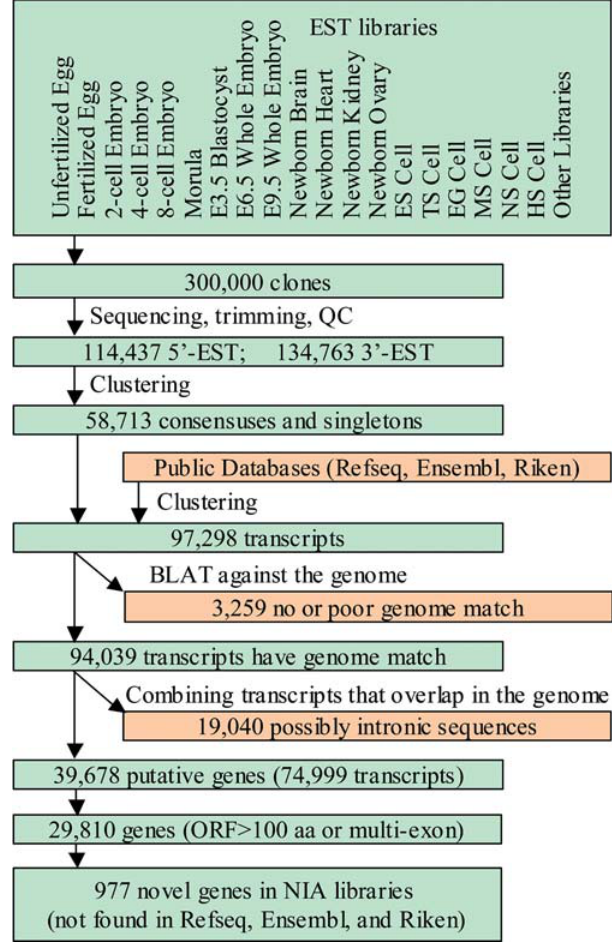
Figure 1. Flow Chart of Sequence Data Analysis Using TIGR gene indices clustering tools (Pertea et al. 2003), 249,200 ESTs were clustered, generating 58,713 consensuses and singletons. NIA consensuses and singletons were further clustered with Ensembl transcripts (Hubbard et al. 2002), RIKEN transcripts (Okazaki et al. 2002), and RefSeq transcripts and transcript predictions (Pruitt and Maglott 2001). Alignments of these sequences to the mouse genome (UCSC February 2002 freeze data, available from ftp://genome. cse.ucsc.edu/goldenPath/mmFeb2002) (Waterston et al. 2002) using BLAT (Kent 2002) helped to avoid false clustering of similar sequences at nonmatching genome locations. Erroneous clusters were reassembled based on the analysis of genome alignment. A total 94,039 putative transcripts were thus generated and then grouped into 39,678 putative genes based on their overlap in the genome on the same chromosome strand and on clone-linking information. Using criteria of an ORF greater than 100 amino acids or of multiple exons (excluding sequences that are potentially located in a wrong strand), 29,810 mouse genes were identified. Finally, 977 genes unique to the NIA database were